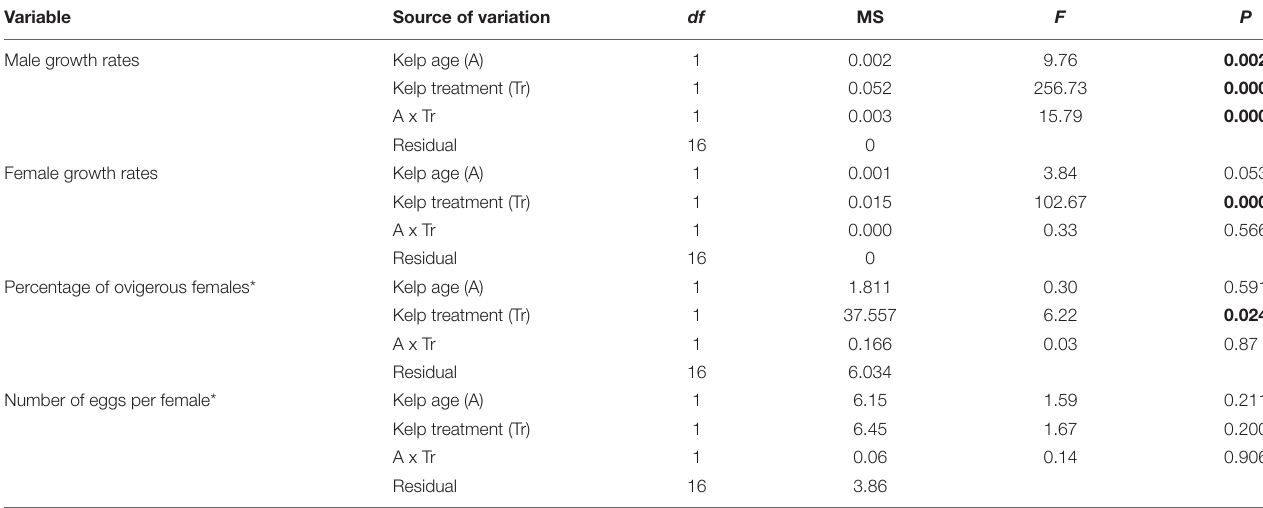
TABLE 2 | Result of two-way ANOVA testing the effect of Treatment (Control and Antibiotic treatment) and Age of kelp (Fresh and Aged kelp) on growth rate of male and female amphipods, percentage of ovigerous female amphipods, and number of eggs per total female amphipods. Variable Source of